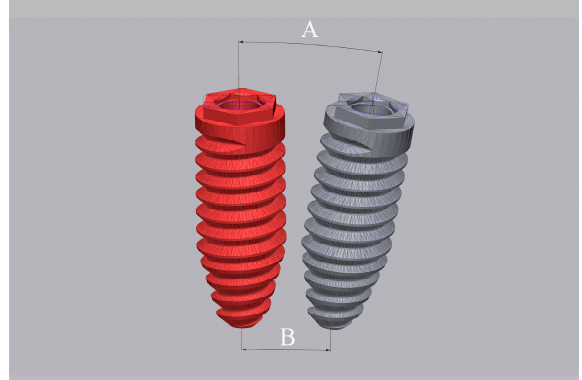
Figure 2. Measuring deviations between planned (red) and placed (gray) implants. ( A ) Angular deviation at the central axis of the implant. ( B ) Linear deviation at implant apex.